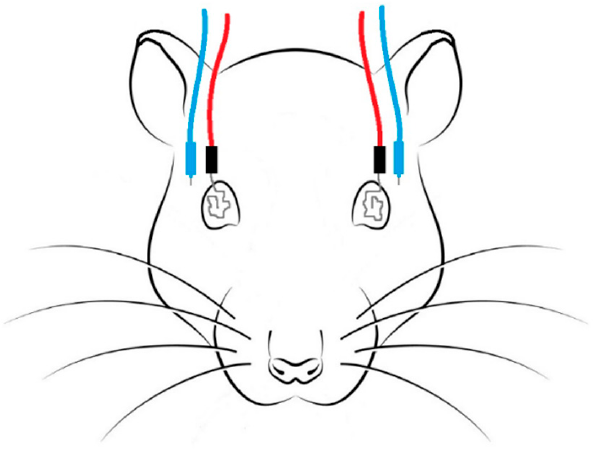
Figure 7. Representation of the ERG setup: active electrodes (red) with silver tips were placed on both corneas, and reference electrodes (blue) were placed subcutaneously between the ears and the lateral canthus ipsilateral to the tested eye.